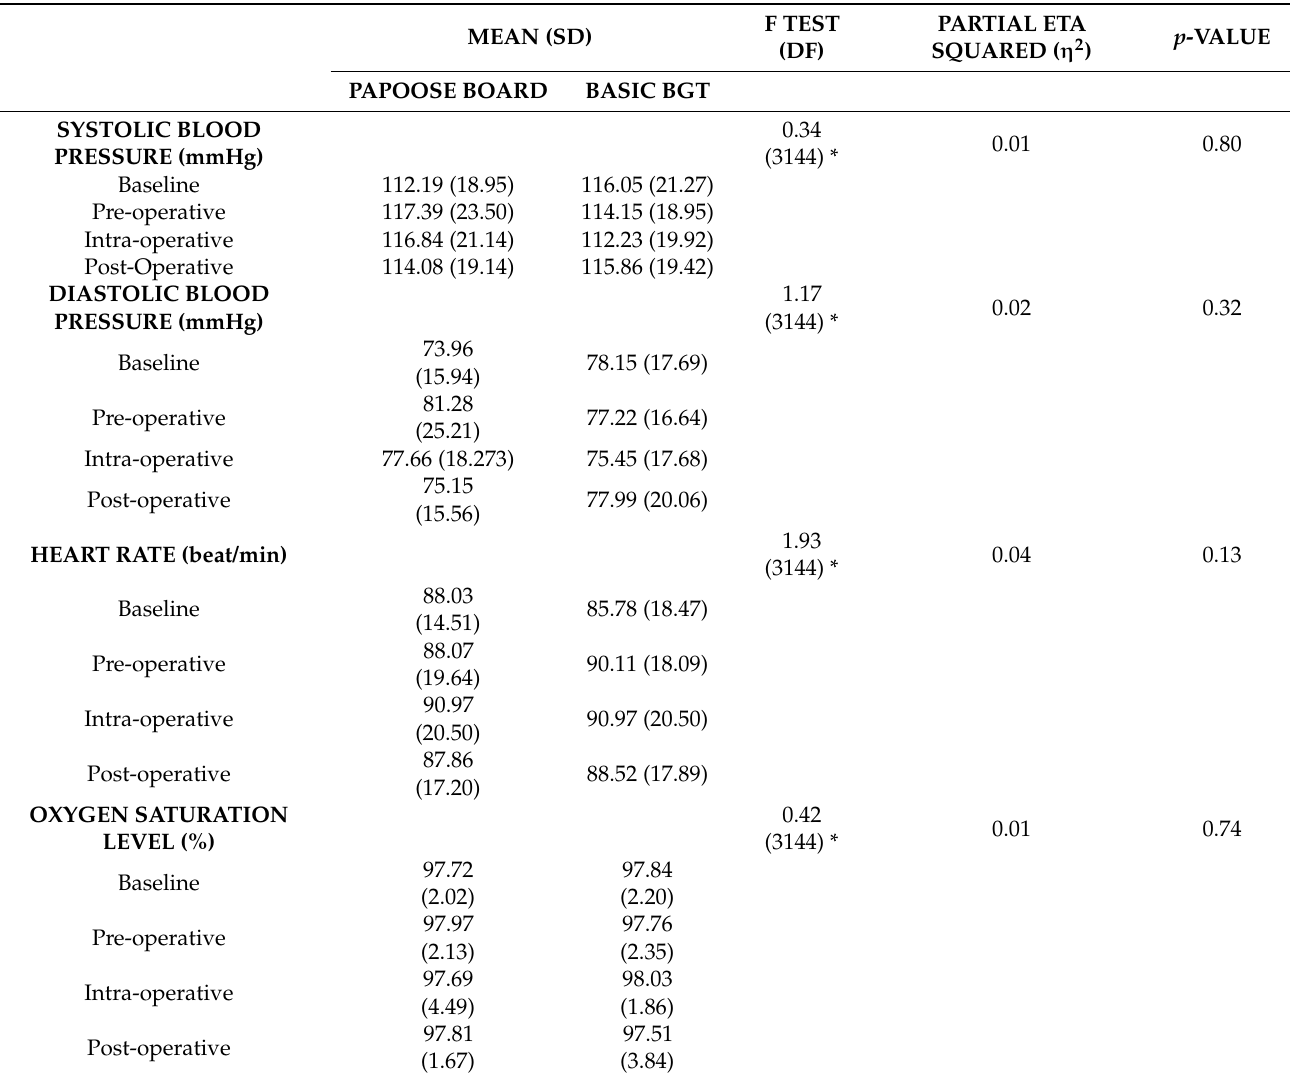
Table 2. Multivariate analyses of repeated measures